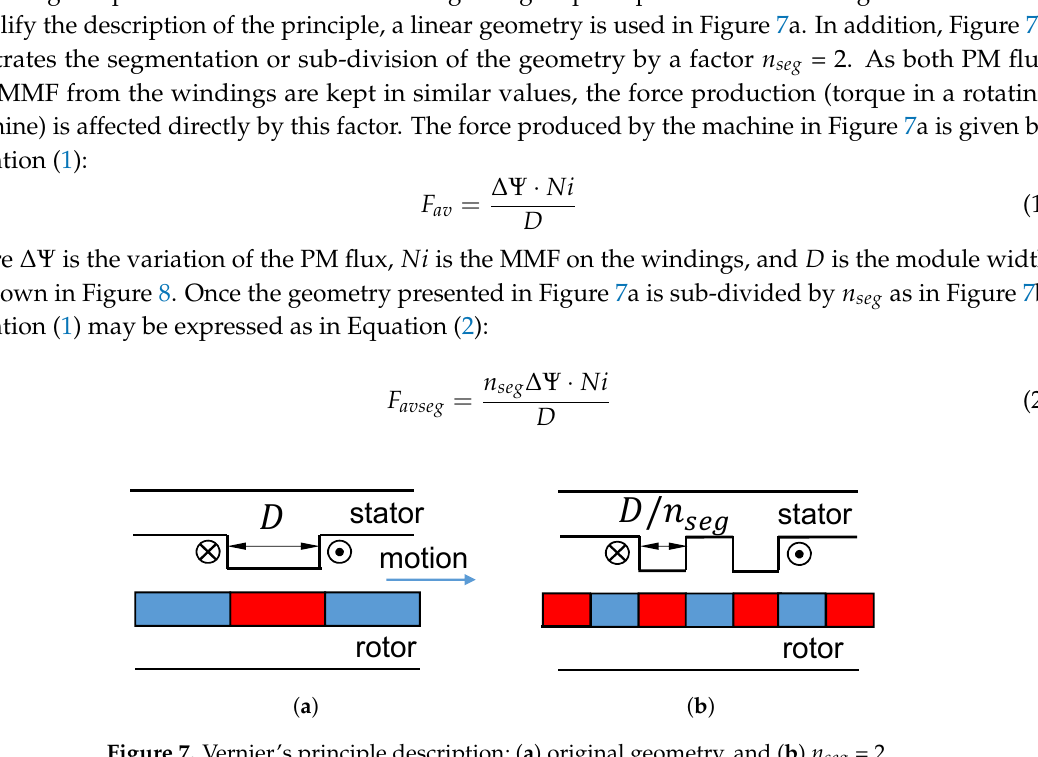
Figure 7. Vernier’s principle description; ( a ) original geometry, and ( b ) n seg =